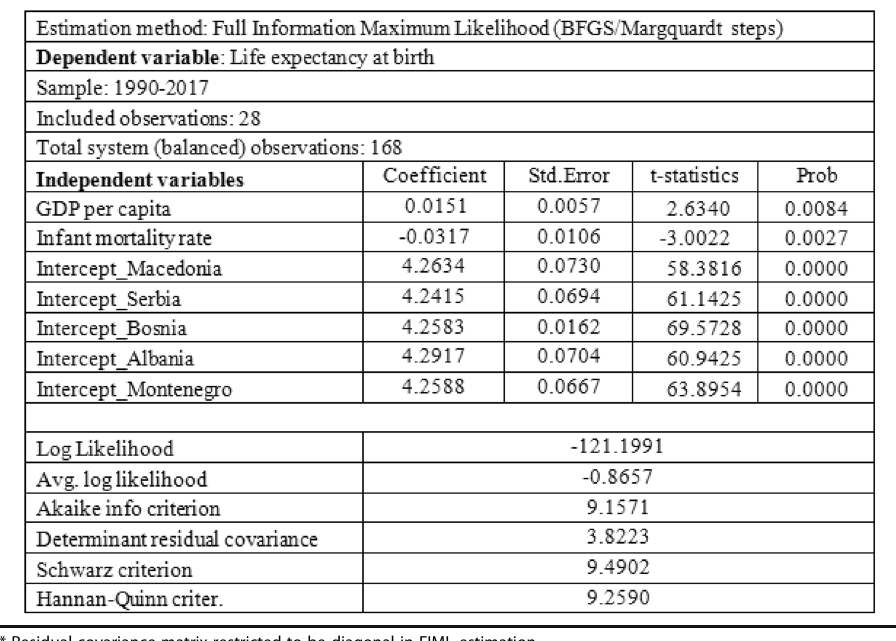
Table 1 Results of FIML method for Life expectancy at birth